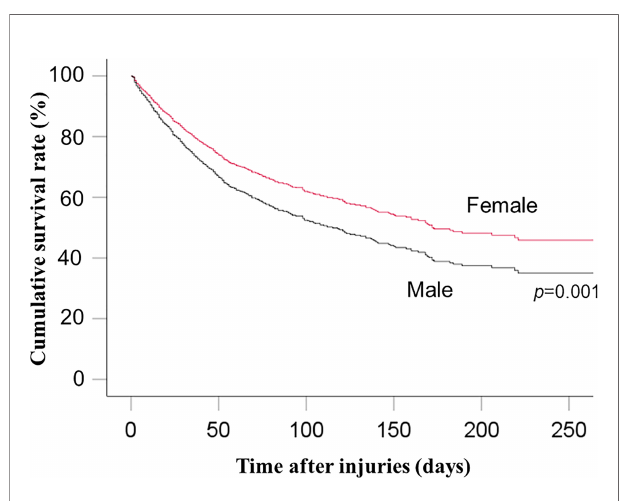
FIGURE 2 | Cumulative survival rate between men